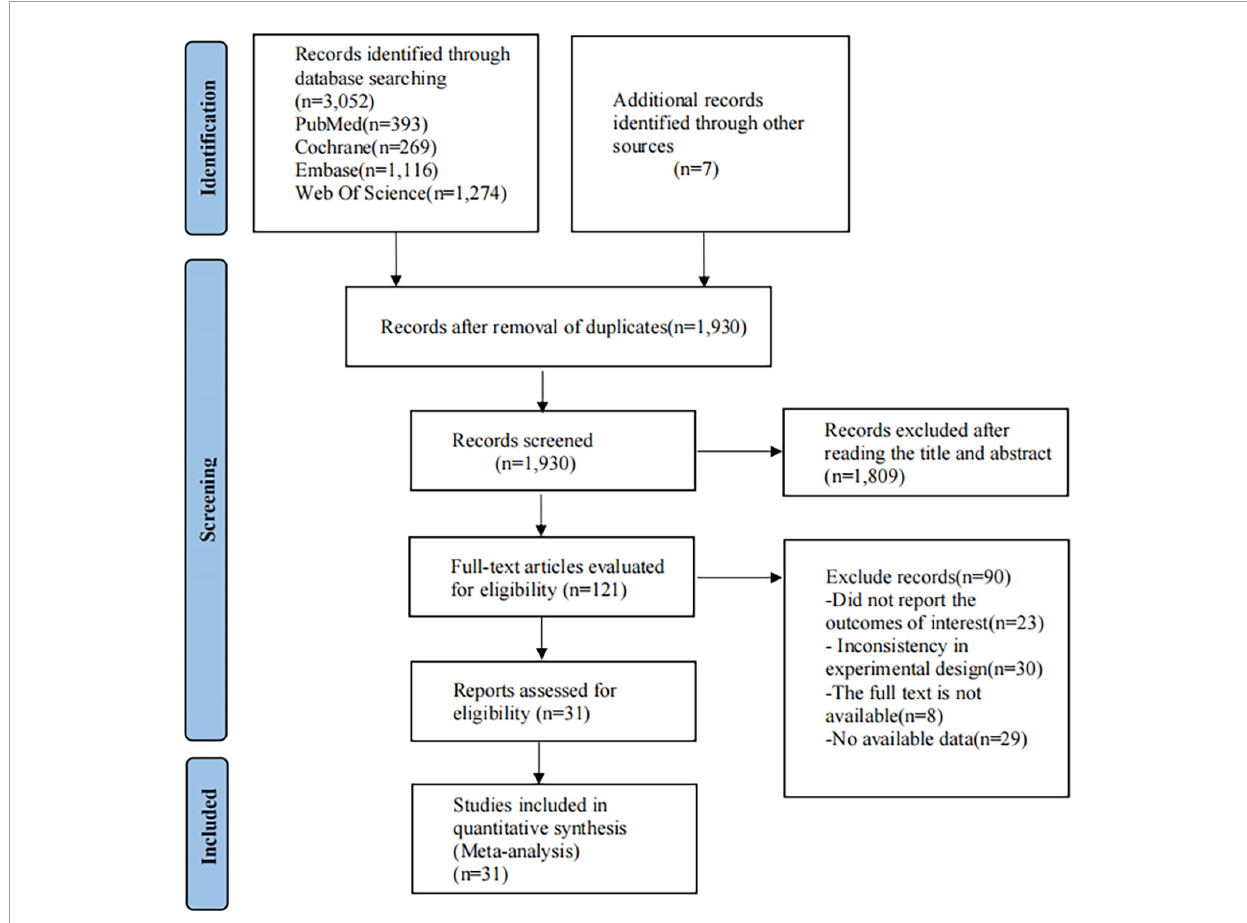
FIGURE1 Preferred Reporting Items for Systematic Reviews and Meta-Analyzes flow diagram of the study process.